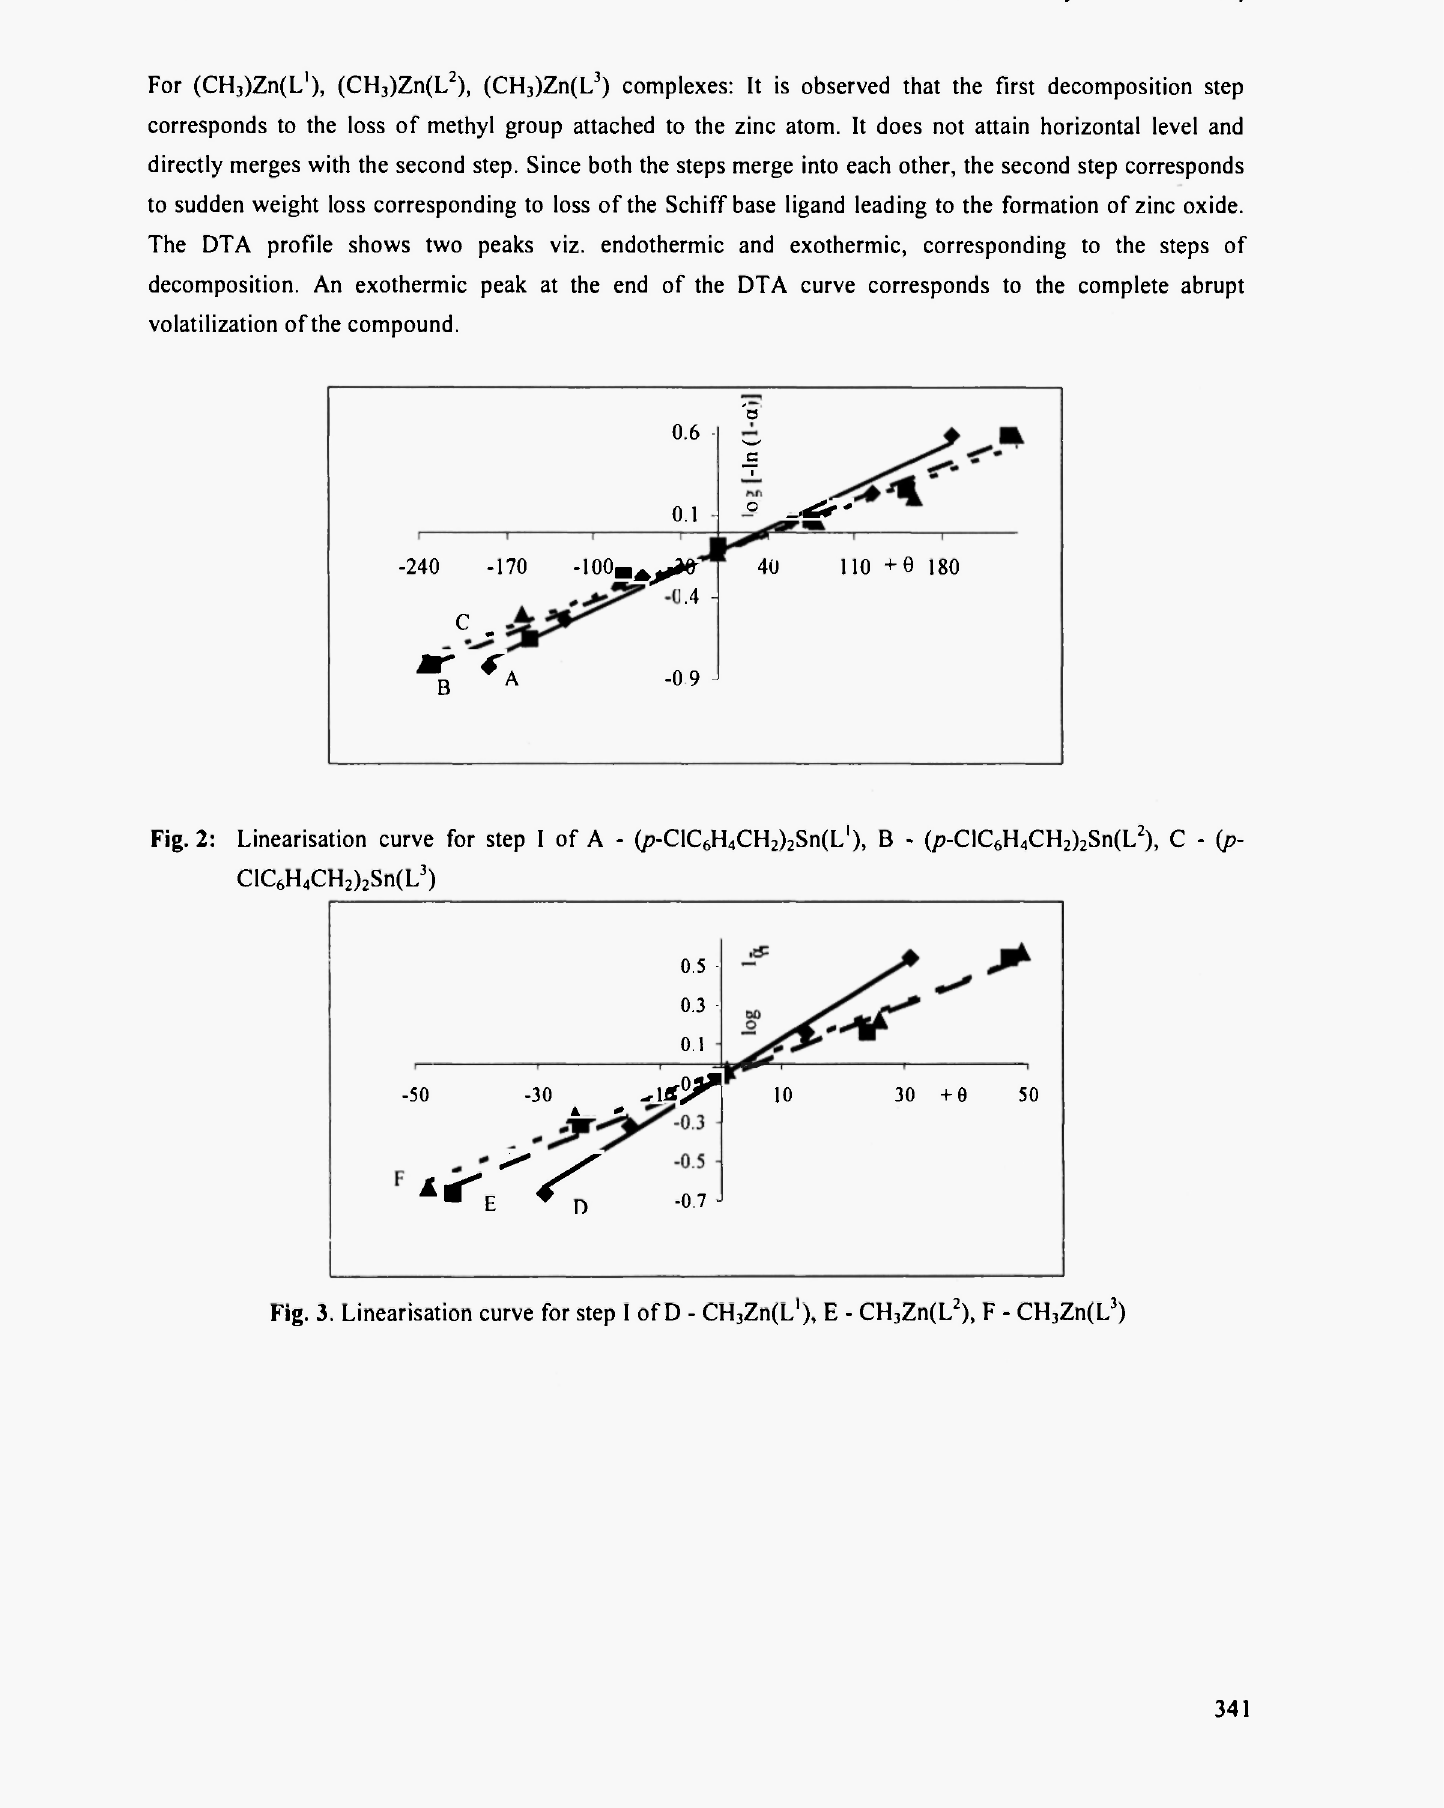
Fig. 3. Linearisation curve for step I of D - CH 3 Zn(L'), Ε - CH 3 Zn(L 2 ), F - CH 3 Zn(L 3